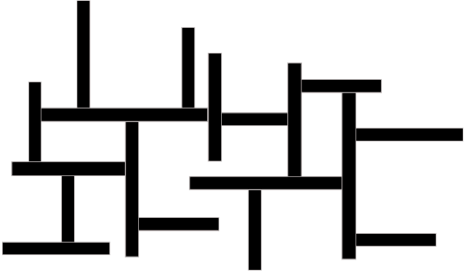
Figure 1. Schematic cubic card house structure.